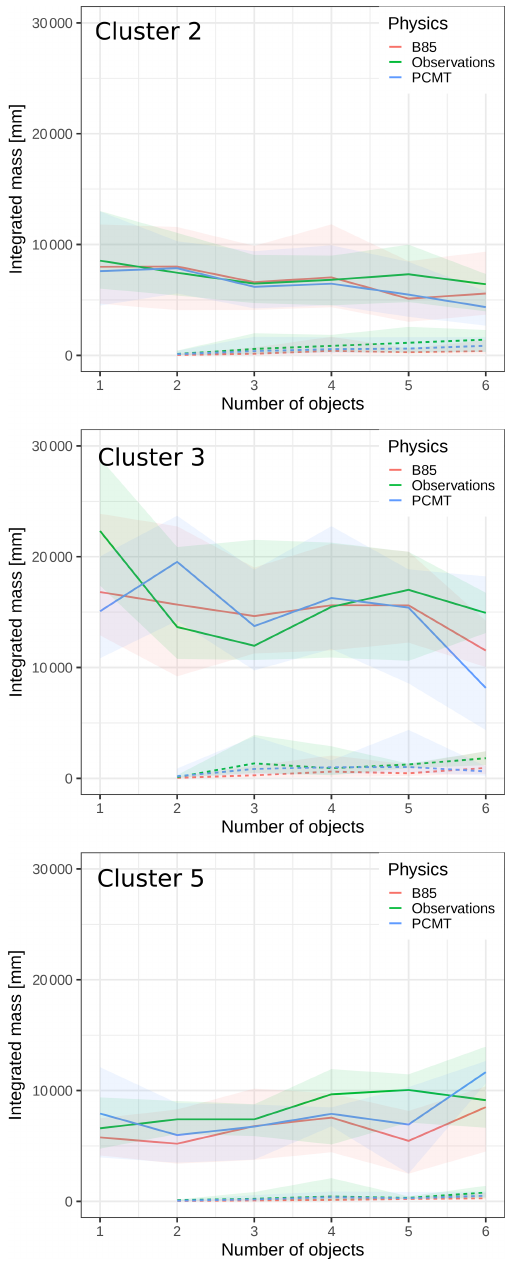
Figure 12. Distribution of the SAL first-pattern O 1 rain amount ac- cording to the number of patterns per day. Curves stand for the me- dian of the distribution, and shaded areas range between the 25th and 75th percentiles. The dashed lines correspond to the second ranked SAL pattern O 2 rain